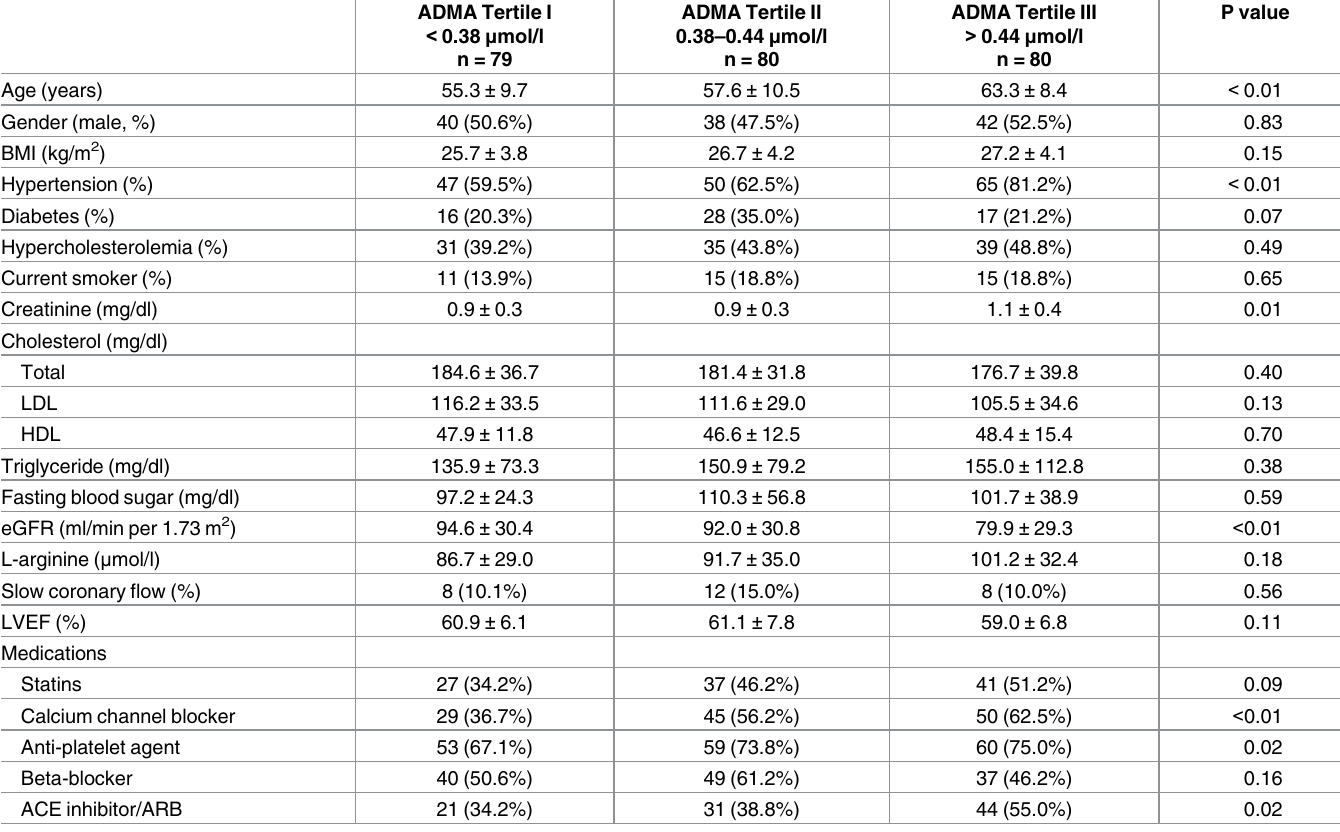
Table 1. Baseline